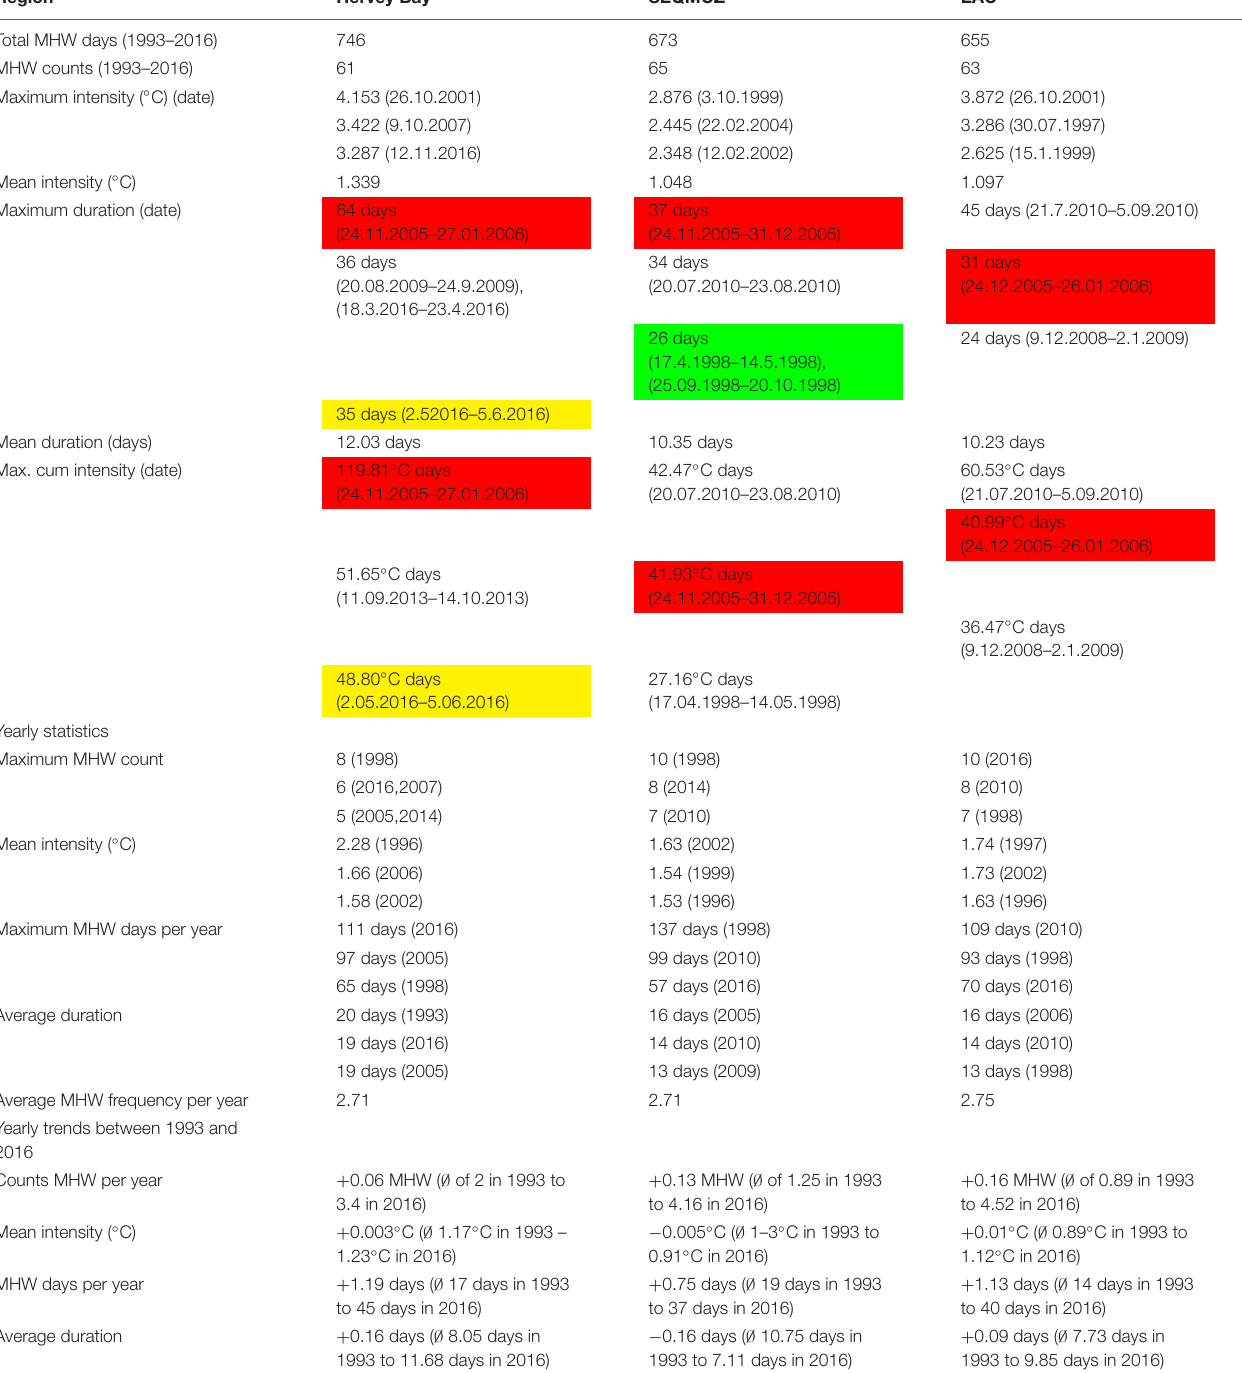
TABLE 1 | Summary of MHW event properties and metrics, divided into Hervey Bay, SEQMCZ and EAC. Region